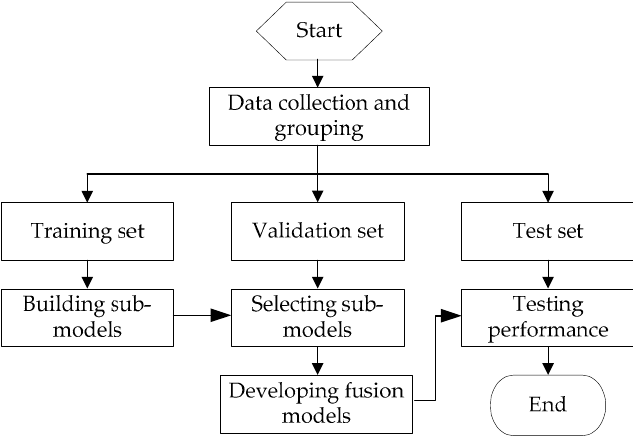
Figure 1. The flowchart of developing multi-model fusion models.